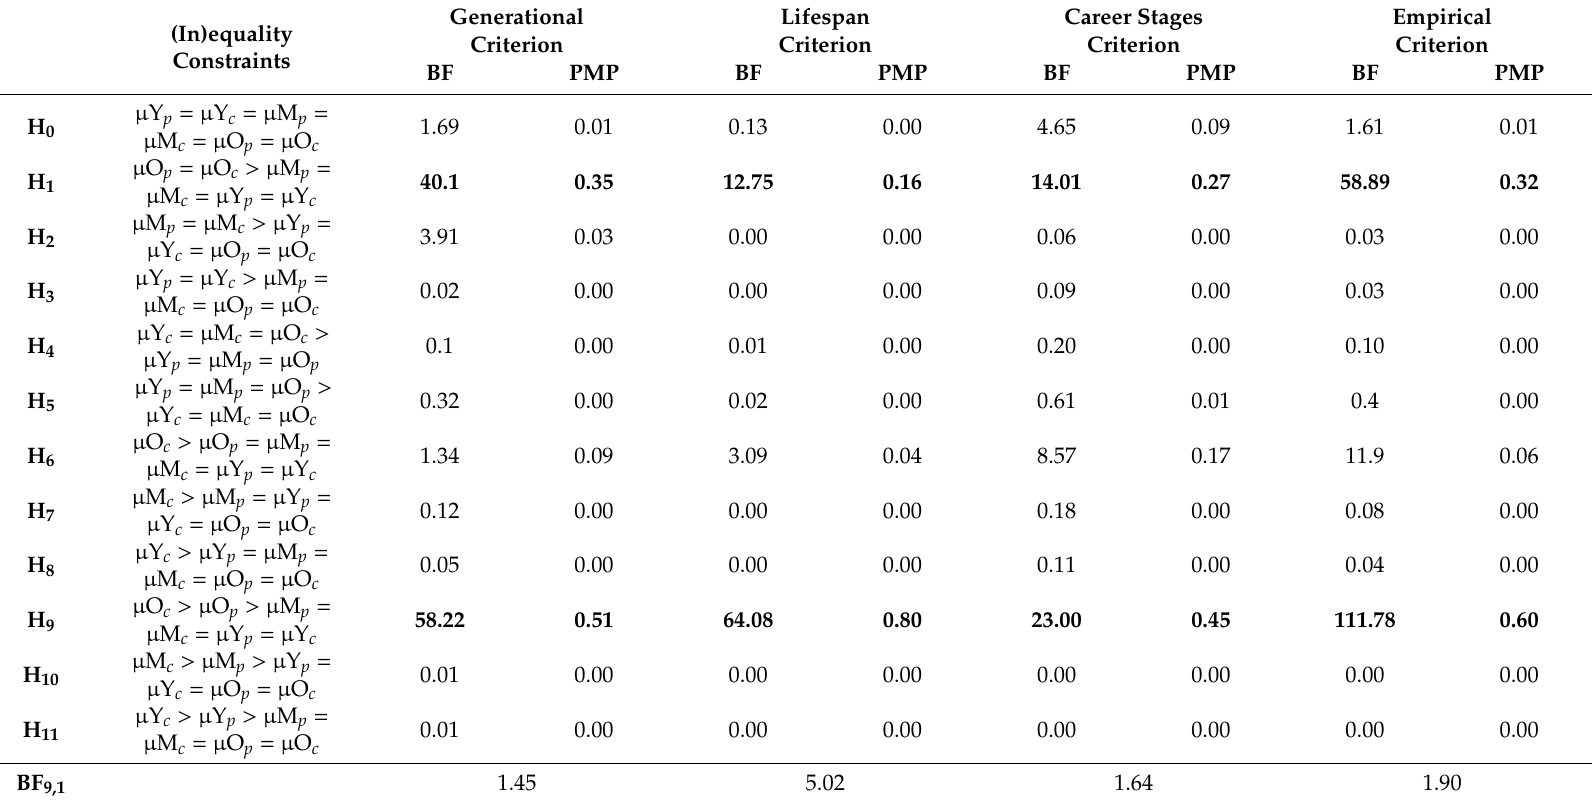
Table 6. Bayesian evaluation of the study informative